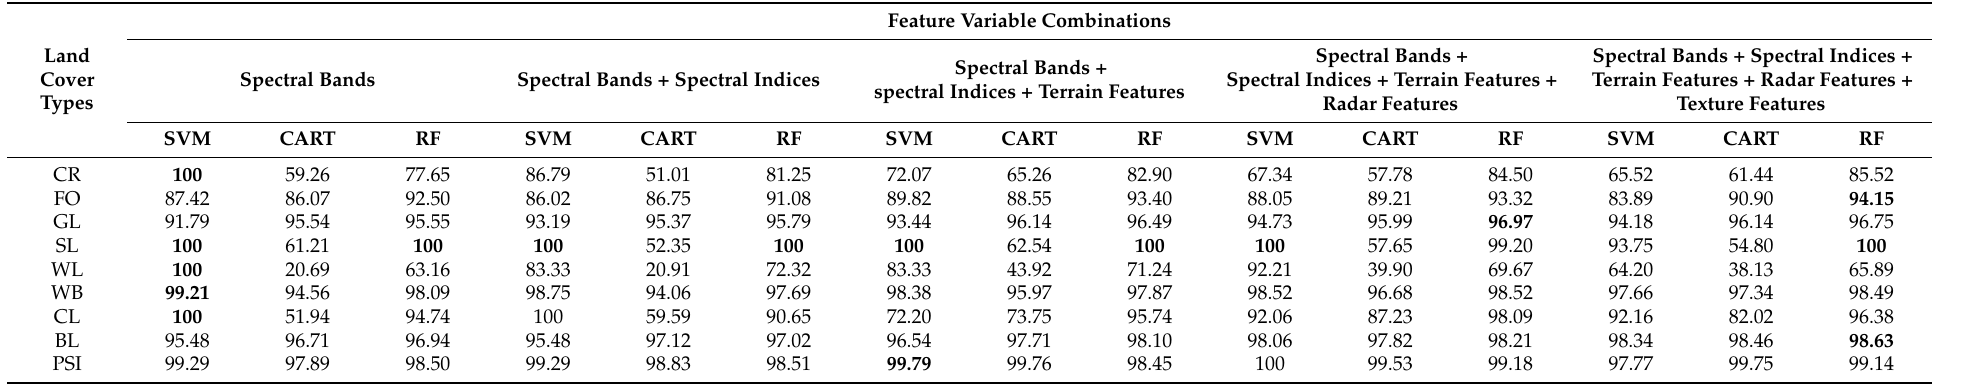
Table A3. Influences of the different feature variable combinations on the user accuracies (UAs) (%) of the different land cover